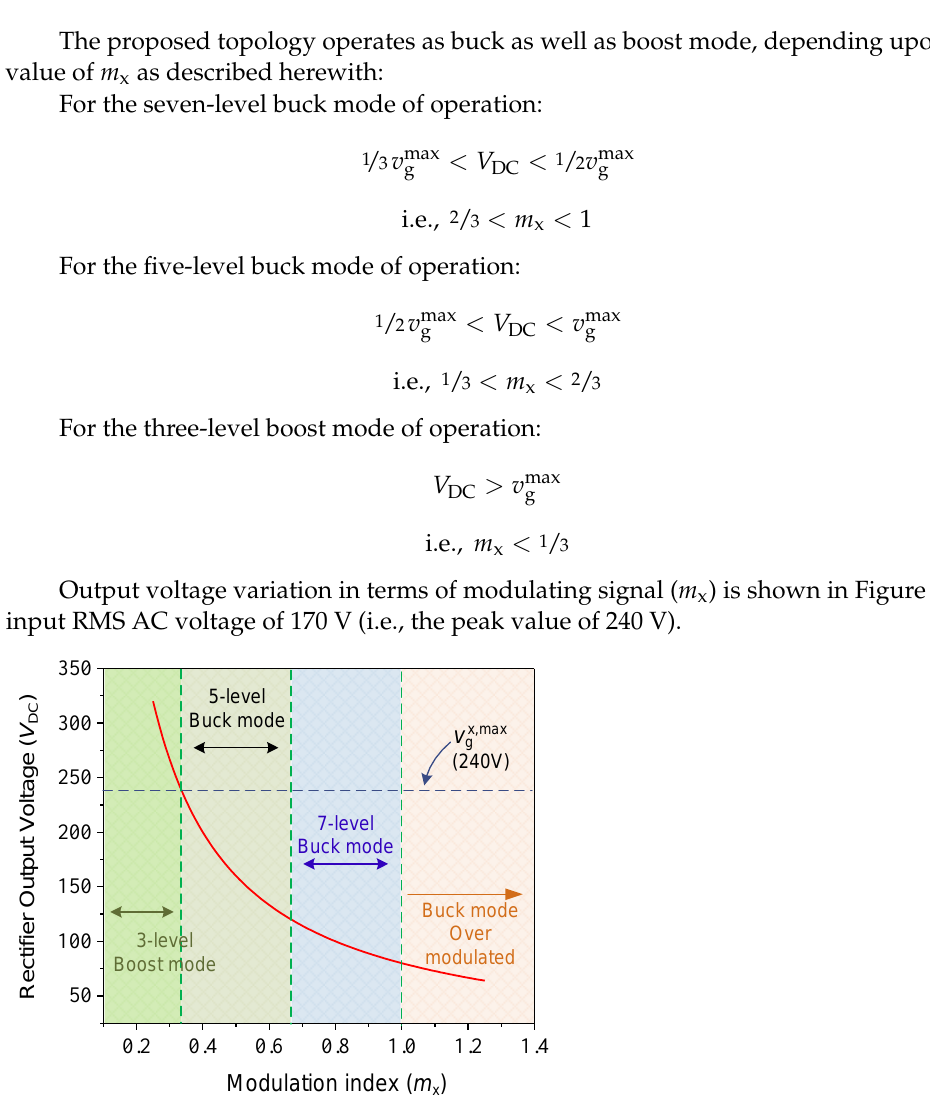
Figure 9. Variation in the output DC voltage with respect to the modulation index for the proposed multilevel rectifier.